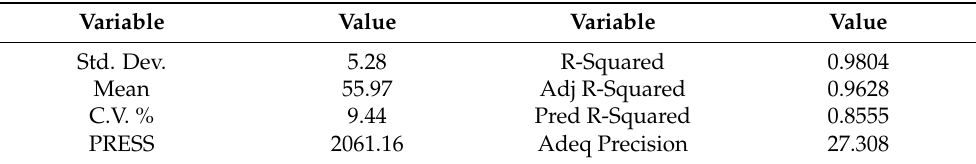
Table 3. Statistical parameters determined using